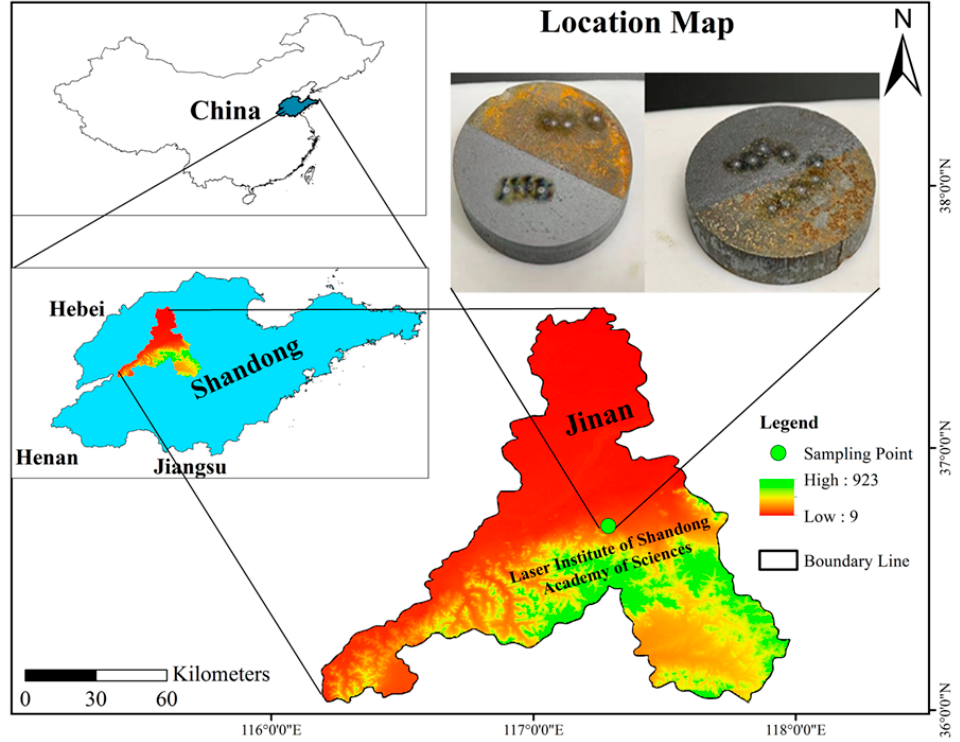
Figure 1. Map illustrating the sampling site location in this study. The inset shows sample 1 (left, half-contaminated with tap water and half-laser-cleaned), and sample 2 (right, half-contaminated with soil and half-laser-cleaned).